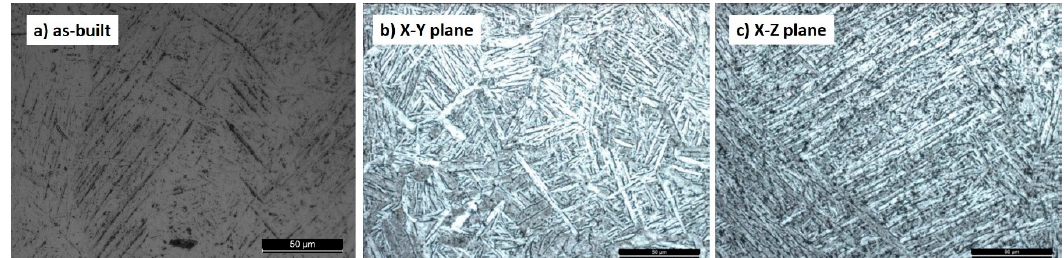
Figure 6. The microstructure of the Ti6Al4V alloy: ( a ) As-built and ( b ) and ( c ) after heat treatment.